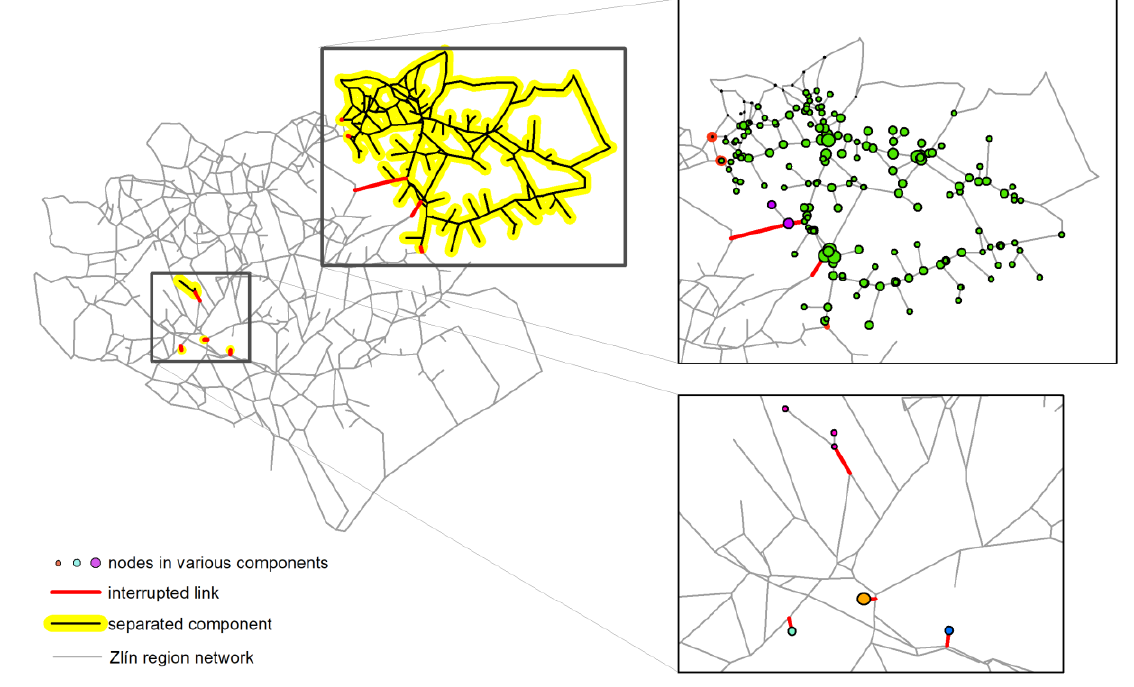
Figure 9. The worst scenario found by ANSA for ten concurrently interrupted road links in the Zlín region network. 142,136 people (24.19%) in six components cut off from the main network.